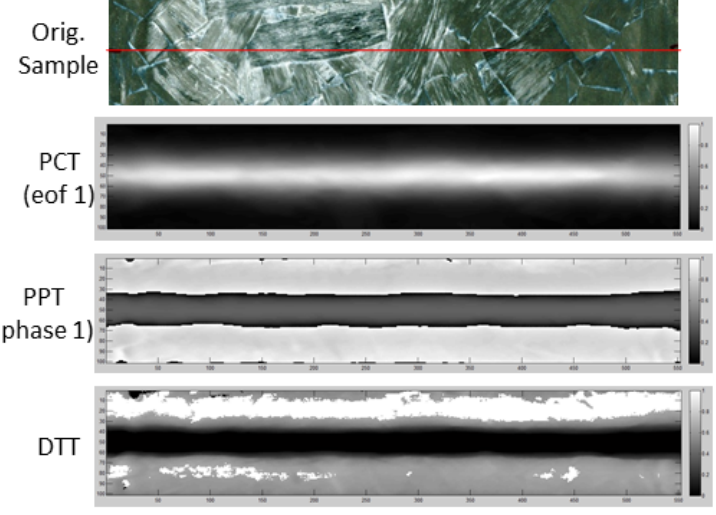
Figure 9. Results obtained with Principal Component Thermography (PCT), Pulsed Phase Thermography (PPT) and Dynamic Thermal Tomography (DTT) applied on the pseudo-static